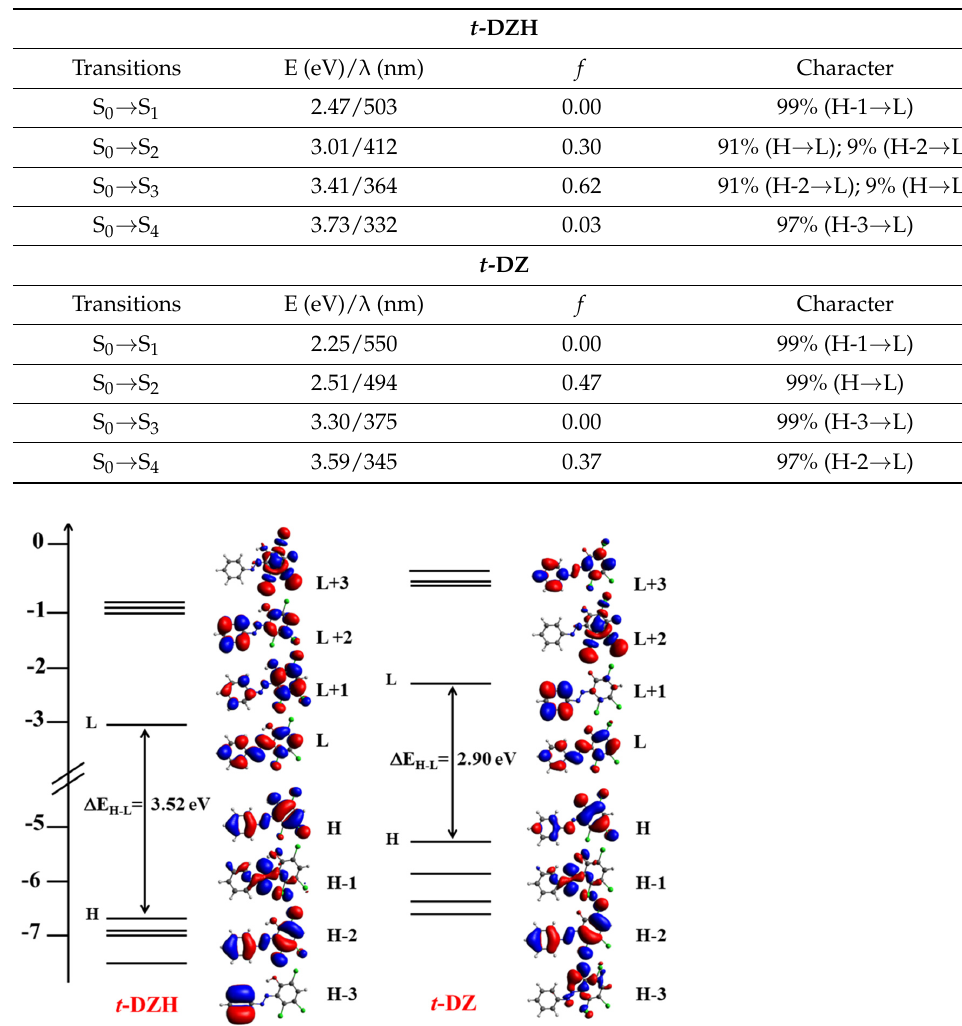
Table 1. Energies, wavelengths, oscillator strengths ( f ), and characters in terms of molecular orbitals of the lowest electronic transitions for t -DZH and t -DZ (H and L stand for HOMO and LUMO). The simulated absorption spectra are reported in Figure S4 of the Supplementary Materials. t -DZH